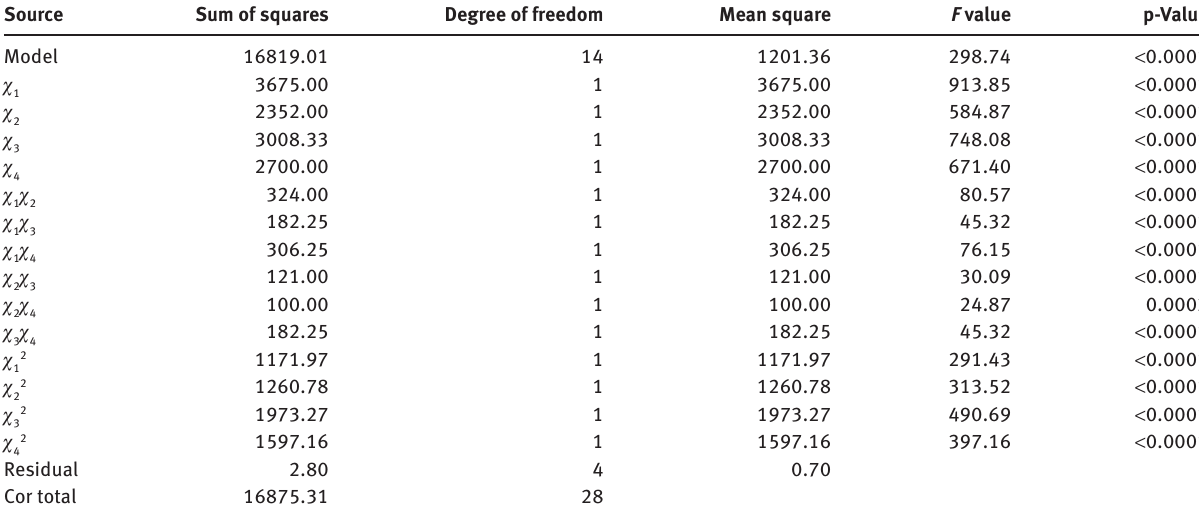
Table 5: Analysis of variance (ANOVA) for response surface cubic model for dechlorination.